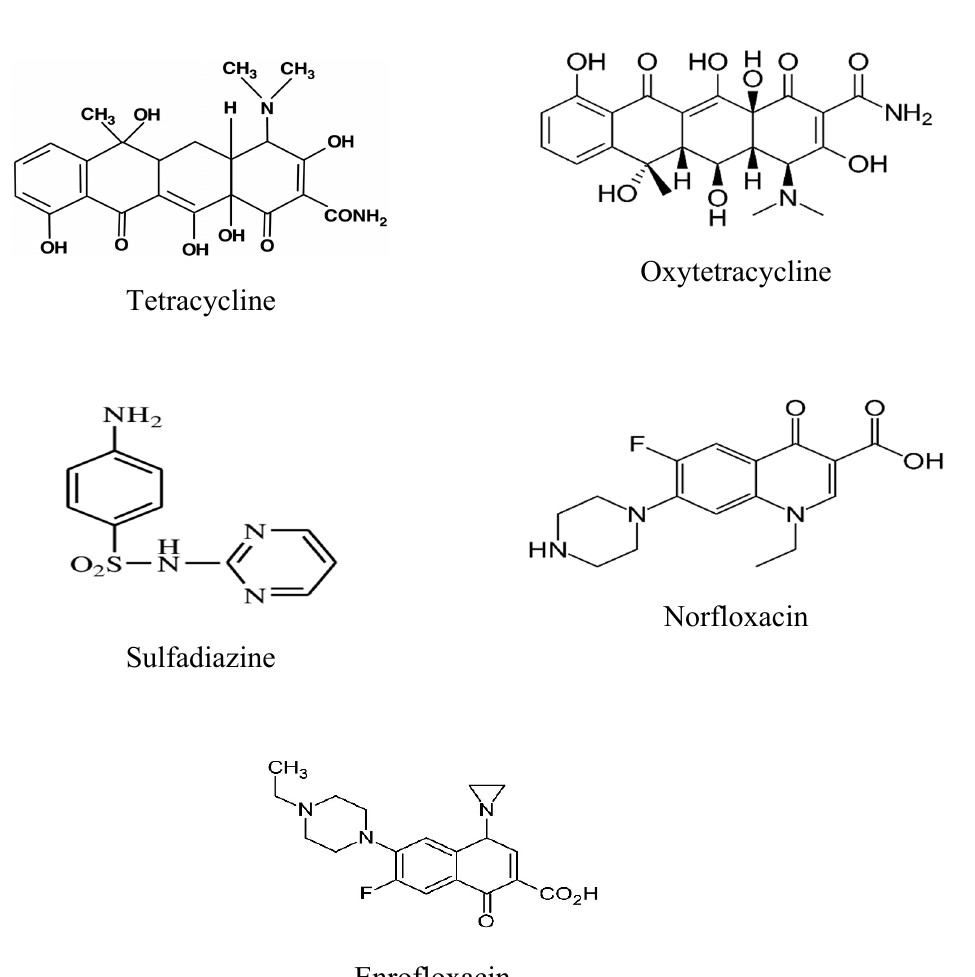
Figure 4. Chemical structure of Tetracycline, Oxytetracycline, Sulfadiazine, Norfloxacin, and Enrofloxacin.